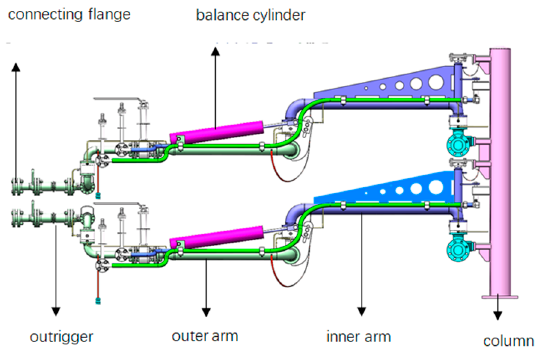
Figure 4. Structure diagram of loading and offloading arm.